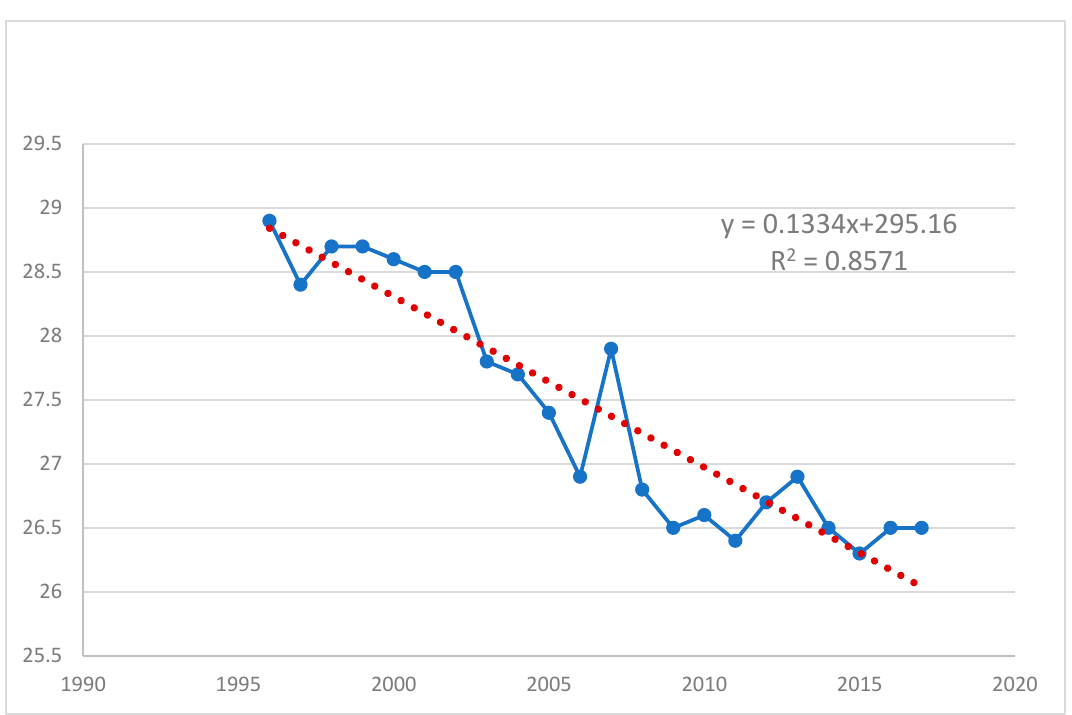
Figure 4. Trend analysis plot for annual temperature ( °C ) in Cross River State. Source: Author’s computation from data obtained from CBN.